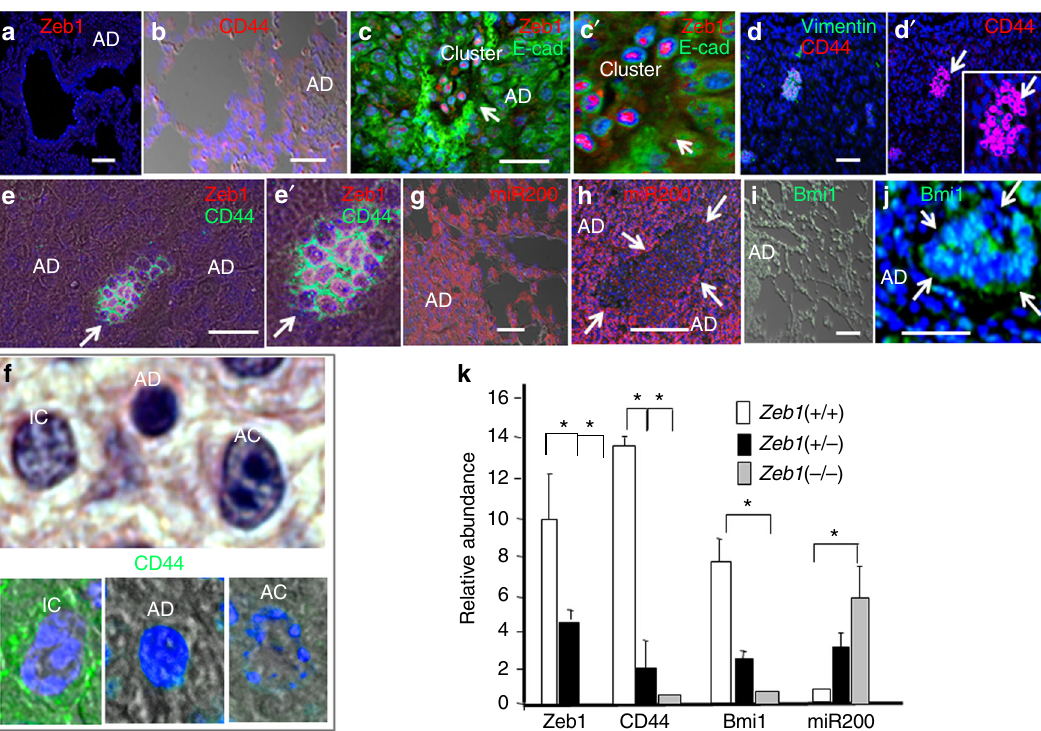
Fig. 2 A CD44/Zeb1 loop marks IC. a Expression of Zeb1 is low in normal lung, AAH, and AD at P170. b CD44 is likewise low in normal lung, AAH, and AD at P170. c , c ′ Zeb1 is induced and E-cad is repressed in cell clusters. d , d ′ CD44 and Vimentin are induced along with Zeb1 in cell clusters. Arrows indicate the same position. e , e ′ Zeb1 and CD44 are co-expressed in cell clusters. Arrows indicate the same position. f In cell clusters, CD44 is expressed on IC but not AD or cancer cells (AC). g In situ hybridization showing miR-200 is low in normal lung, AAH, and AD. h miR-200 is repressed in clusters. Arrows show the border of the cluster. i Bmi1 is low in normal lung, AAH, and AD. j Bmi1 is induced in clusters. k Real-time PCR showing heterozygous mutation of Zeb1 in mouse embryo fi broblasts (MEFs) is suf fi cient for induction of miR-200, and repression of CD44 and Bmi1 mRNAs in cell culture. Bars are 50 μ